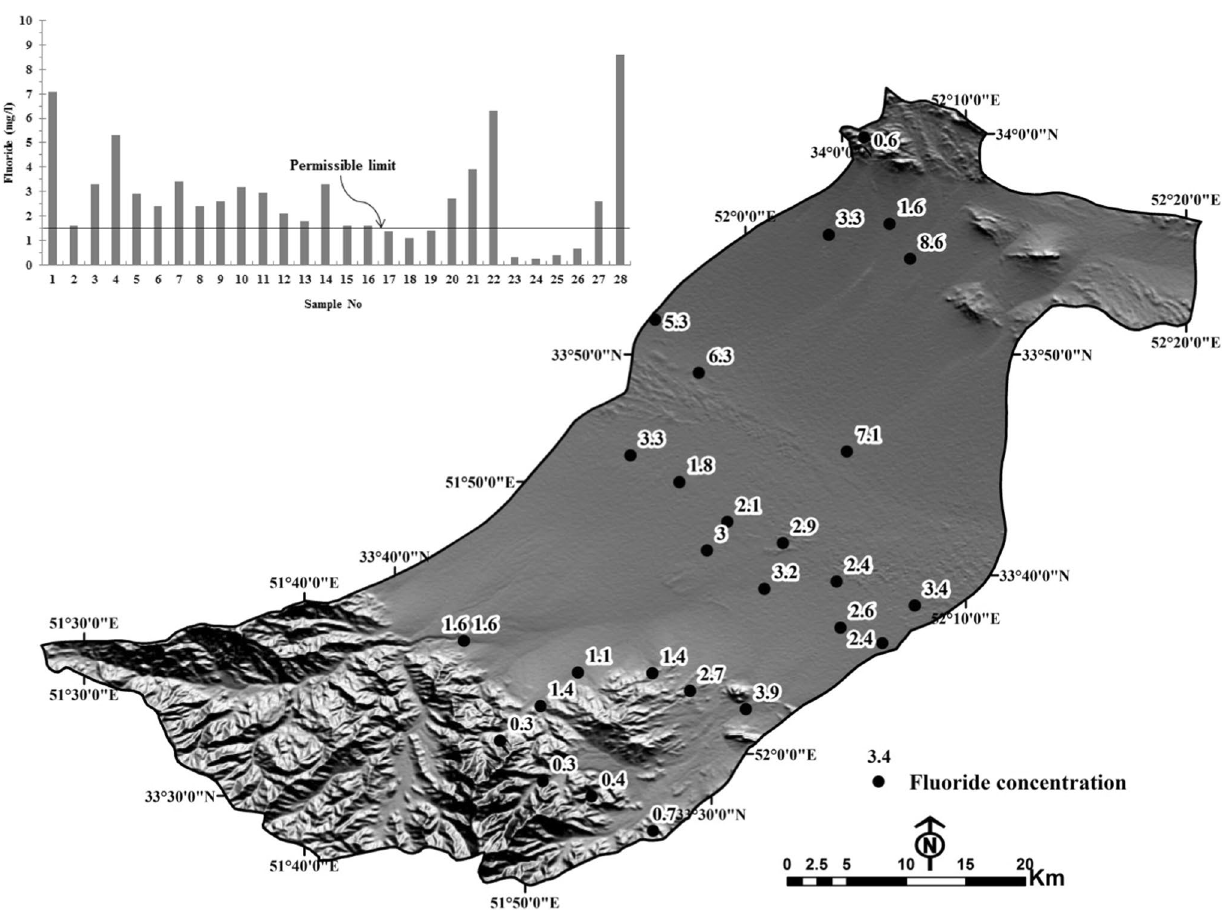
Fig. 3 Fluoride concentration of groundwater in Khaled-Abad